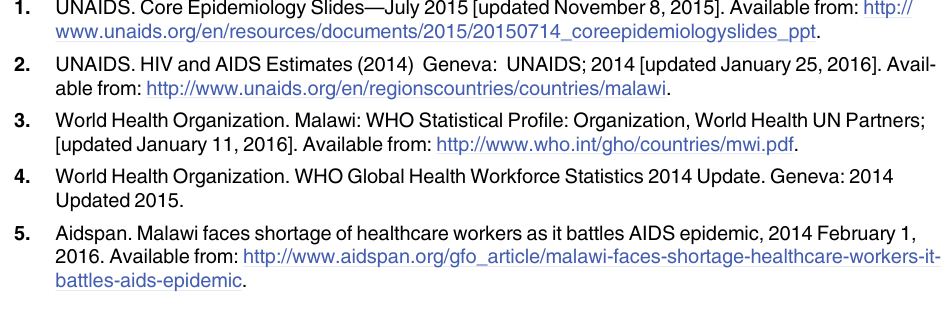
S1 Fig. MOH Self-Assessment Form. S2 Fig. Quarterly Dashboard